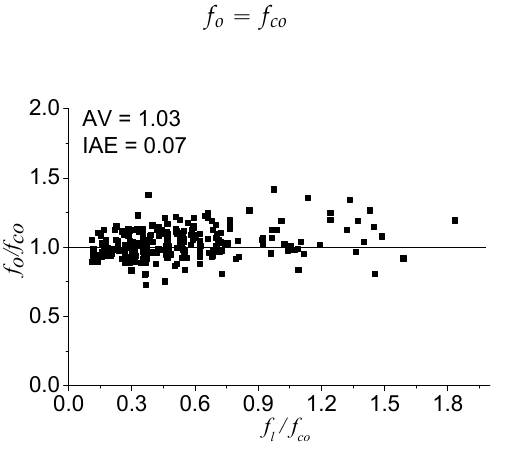
Figure 5. The performance of f o .